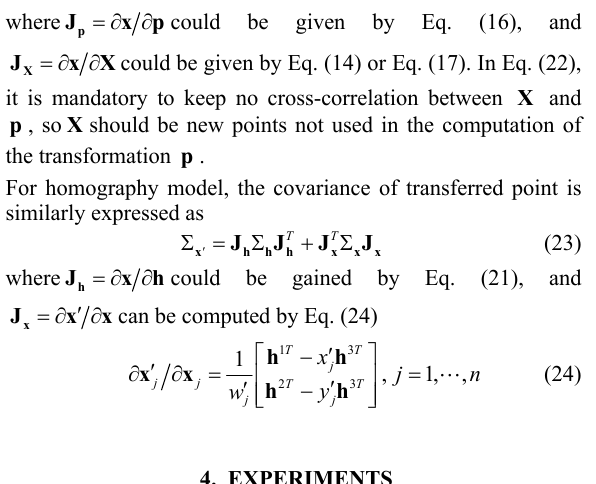
X , l , which are X